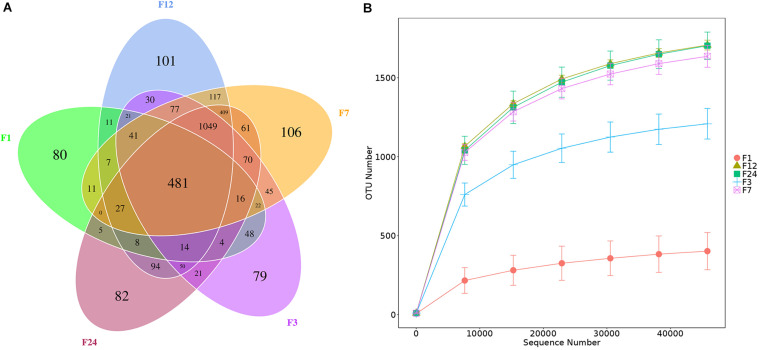
Numbers of bacterial operational taxon units (OTUs) in the feces of donkeys at different ages. Venn diagram, where areas of overlap indicate the numbers of OTUs shared among the overlapping groups (A). Rarefaction curve showing the number of OTUs recovered at different sequencing depths (B). F1: at month 1; F3: at month 3; F7: at month 7; F12: at month 12; F24: at month 24.